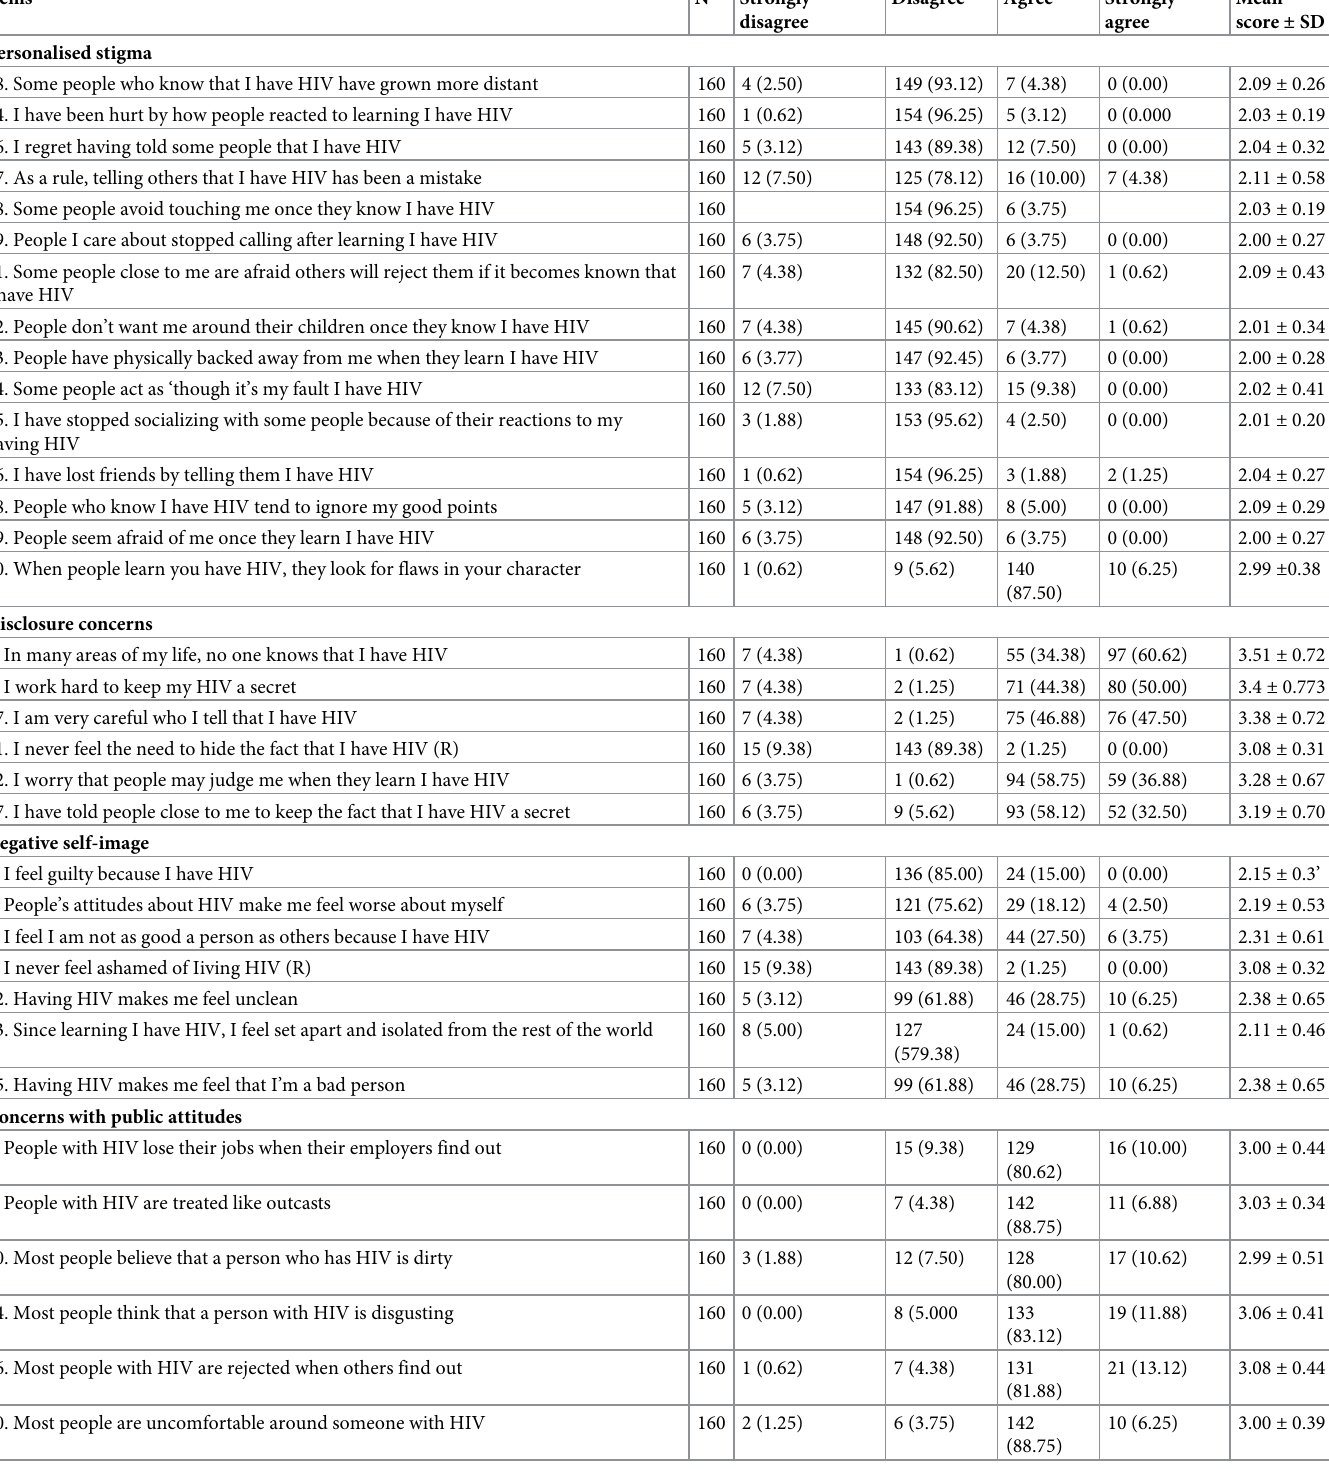
Table 3. Descriptive analysis of items with loading factor > 0.6 in the HIV stigma